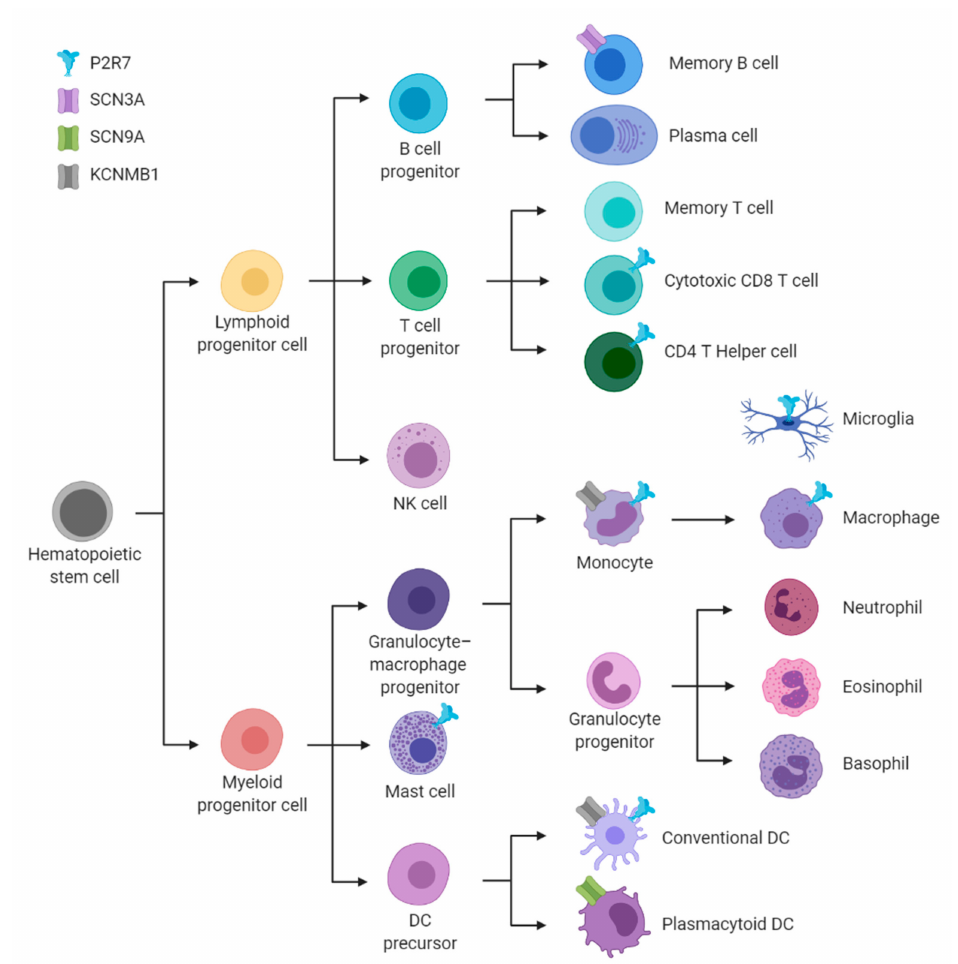
Figure 4. Overview of the key immune cell types from the hematopoietic lineage with an abstraction of their cellular expression of the ion channels discussed in this article. These channels are represented by icons of different colours: blue Figure 2. X7R, purple for SCN3A, green for SCN9A and grey for KCNMB1. This overview is derived from consensus of four independent transcriptomic data sets from human immune cells [31–33], as summarized in Supplemental Figure S1. Figure 4 was created in BioRender